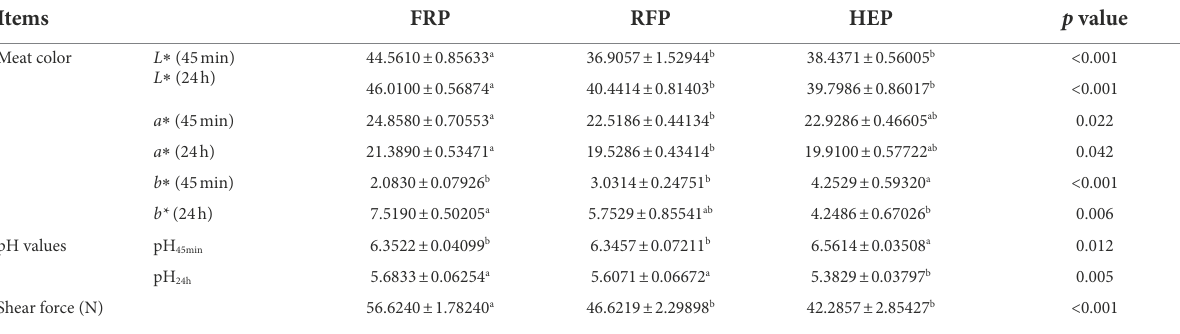
Values in the same row with different superscripts (a, b) are significantly different ( p < 0.05) ( n = 6–7). L * (45 min) or L * (24 h): the lightness of meat color after slaughter 45 min or 24 h; a * (45 min) or a * (24 h): the redness of meat color after slaughter 45 min or 24 h; b * (45 min) or b * (24 h): the yellowness of meat color after slaughter 45 min or 24 h; pH 45min or pH 24h : the pH value of meat after slaughter 45 min or 24 h. FRP: free-ranging Tibetan pigs; RFP: feeding the regular Tibetan pig diets; HEP: feeding the high energy content